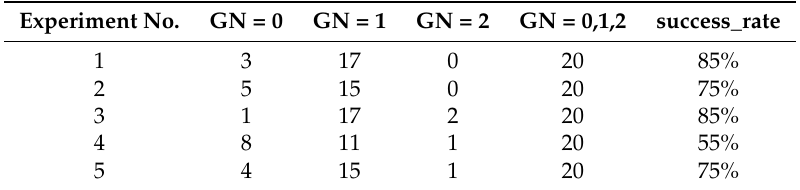
Table 6. Picking the white square towels on the table with our method (GN: the number of towels